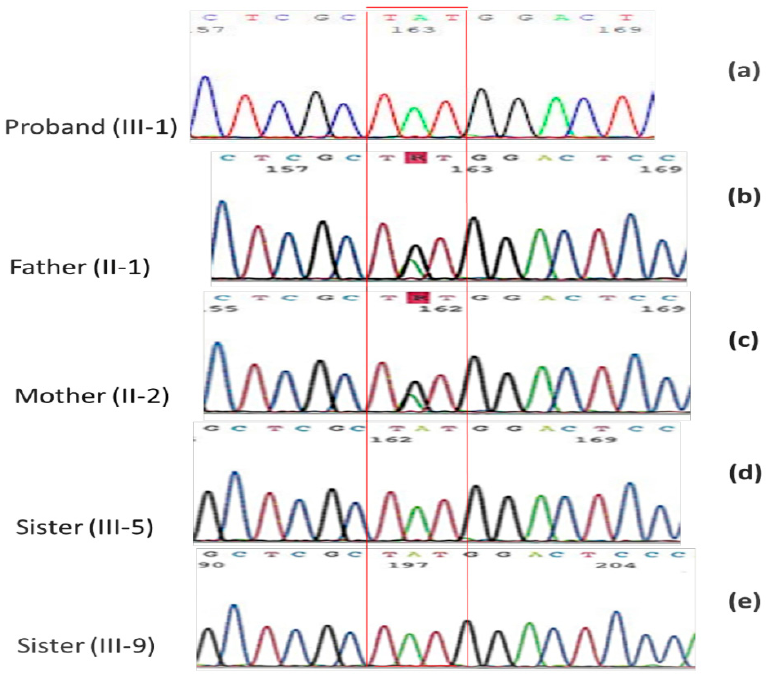
Figure 2. Electropherogram obtained from Sanger sequencing. ( a ) homozygous missense variation in DYSF c.5033G>A, p.Cys1678Tyr (NM_003494) in the proband; ( b , c ) the healthy father and mother heterozygous for c.5033G>A p.Cys1678Tyr variation; ( d , e ) the proband’s sisters homozygous for the same missense variation.